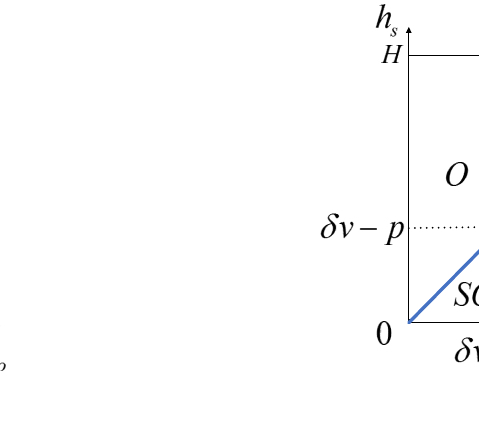
Figure 2. Market segmentation of H-type and L-type consumers when β o + β s > 1. ( a ) H-type consumers; ( b ) L-type